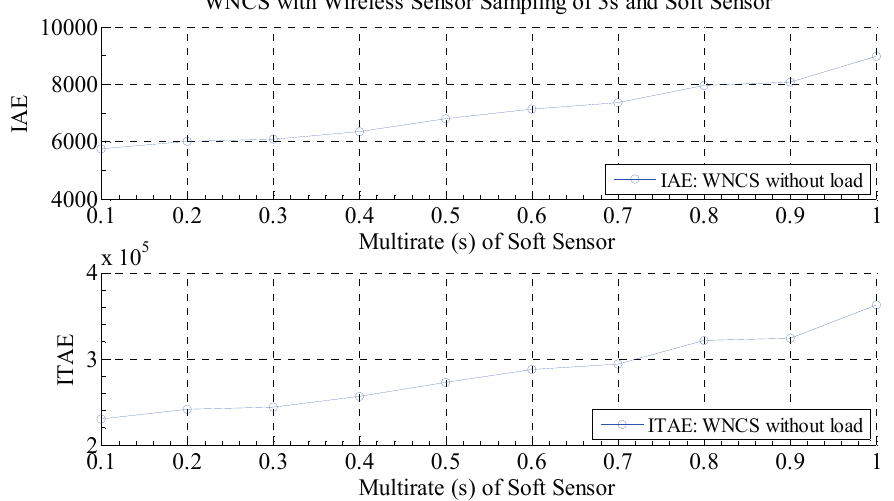
Figure 12. Performance indexes of the WNCS without disturbance: wireless sensor with real sampling period of 3 s and soft sensor with different multi-rate sampling periods.